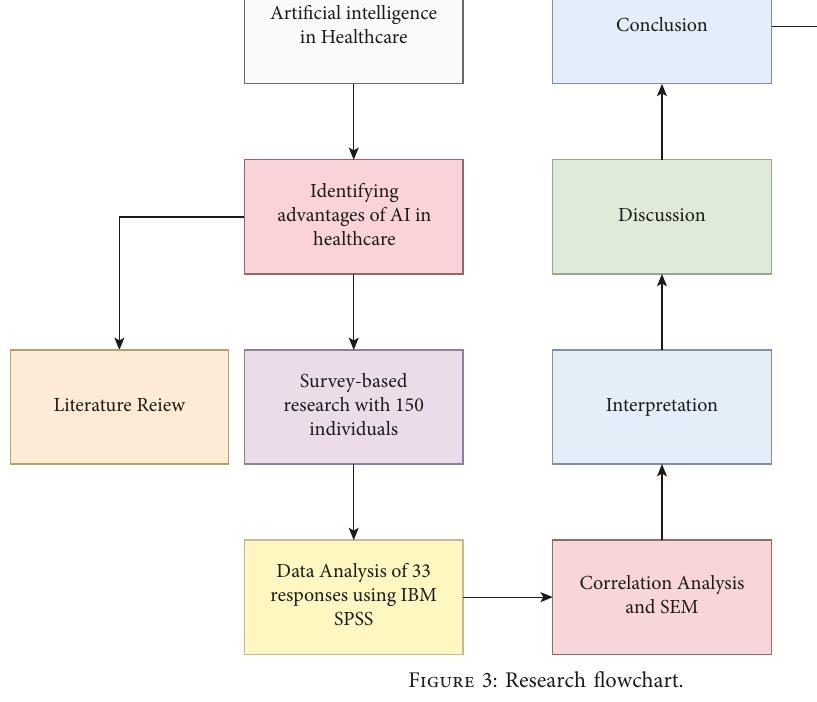
Figure 3: Research flowchart.